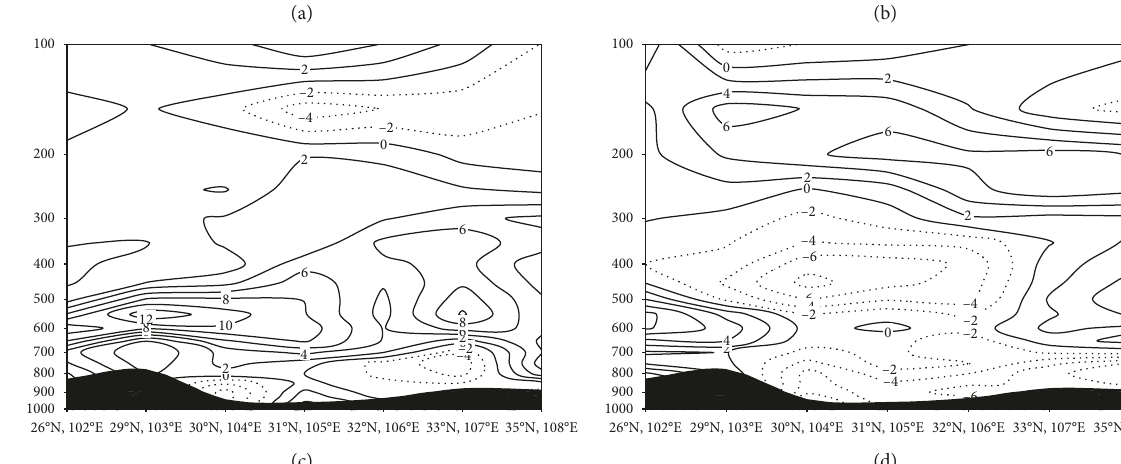
Figure 9: As in Figure 7 but for